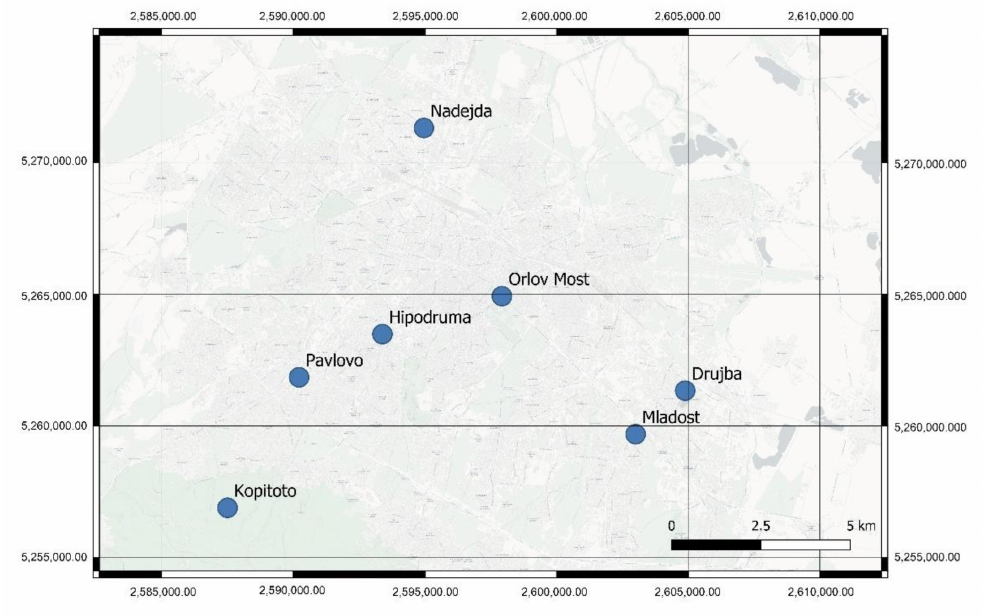
Figure 2. Air quality stations in Sofia